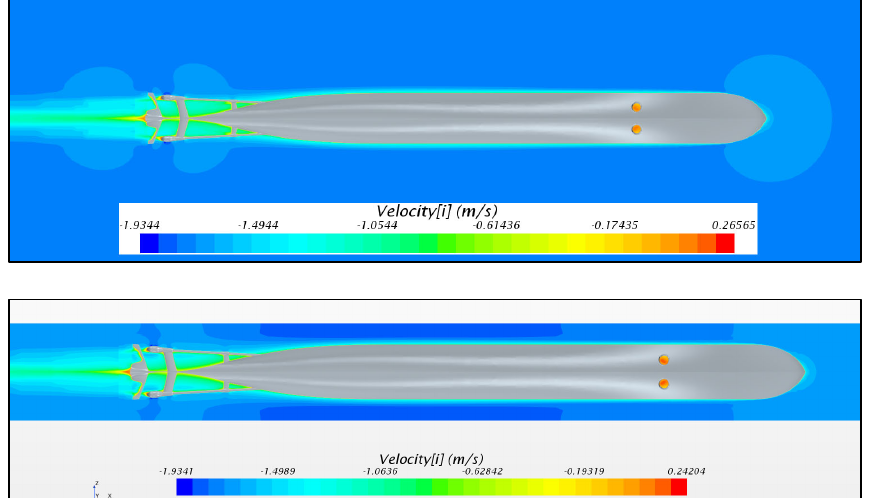
Figure 15. Velocity contours on the centre plane of the demihull at Fr = 0.24 in deep ( top ) and shallow ( bottom ) waters.